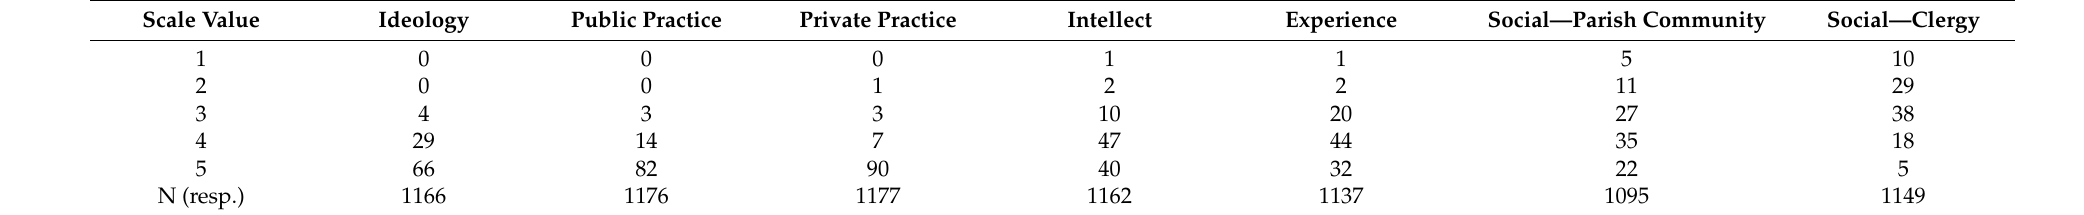
Table 4. Linear distributions of the CRS-SOC items: Parish sample (column